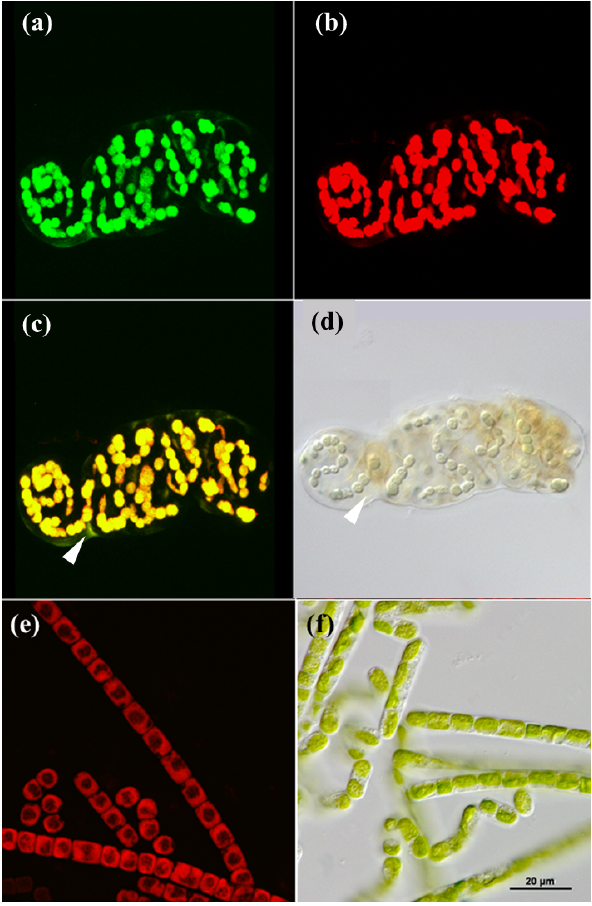
Figure 1. CLSM and light microscopy micrographs of photoau- totrophic organisms. Nostoc sp. (cyanobacterium) visualized with CLSM (a–c) and light microscopy (d) with white triangles indicat- ing the EPS (c, d) . Klebsormidium sp. (green algae) visualized with CLSM (e) and light microscopy (f) . Green channel (a) represents fluorescence from phycobilins at 639nm, red channel (b, e) from chlorophyll a at 555nm and an overlap of both is shown in (c) for Nostoc